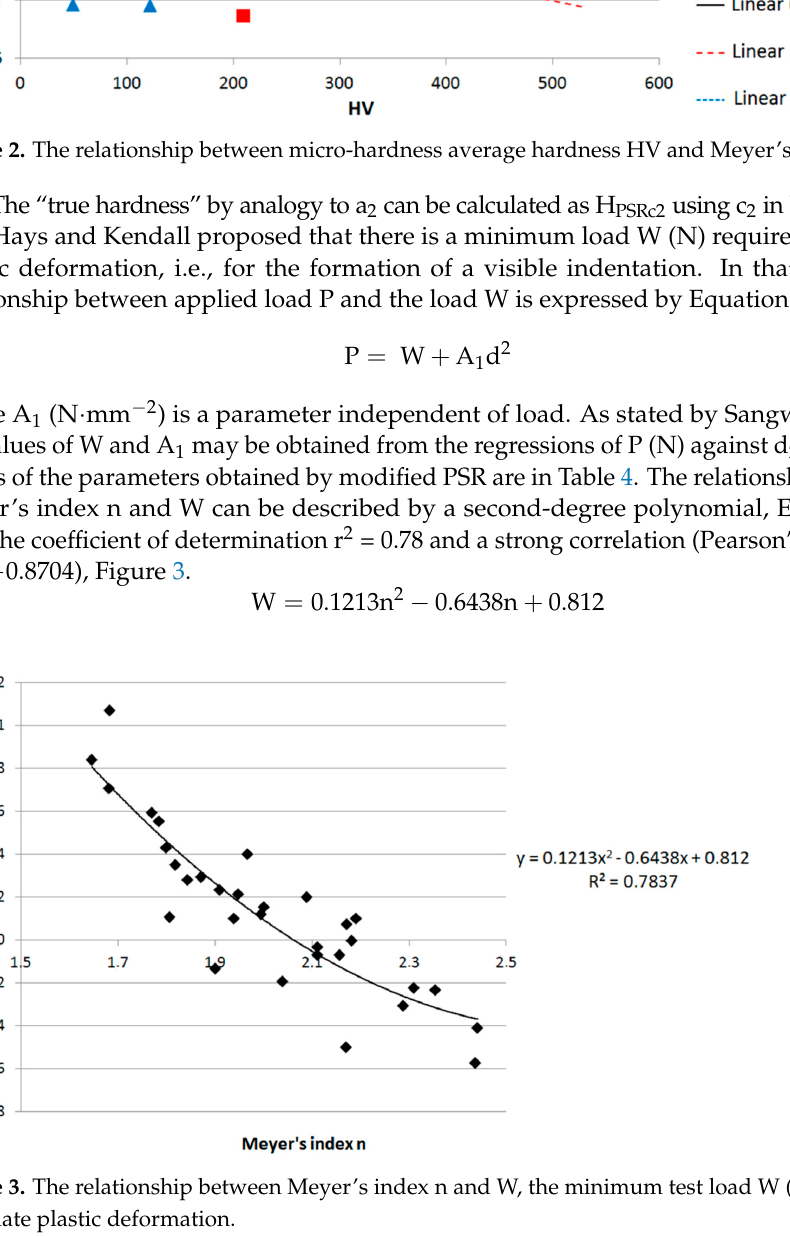
Figure 4. The relationship between measured hardness HV0.05 and calculated values of “true hardness” (H PSR ) relationship between Meyer’s index n and W, the minimum test load W (N) nec- essary to initiate plastic deformation. Table 5. The vales of “true hardness”. Sample No.